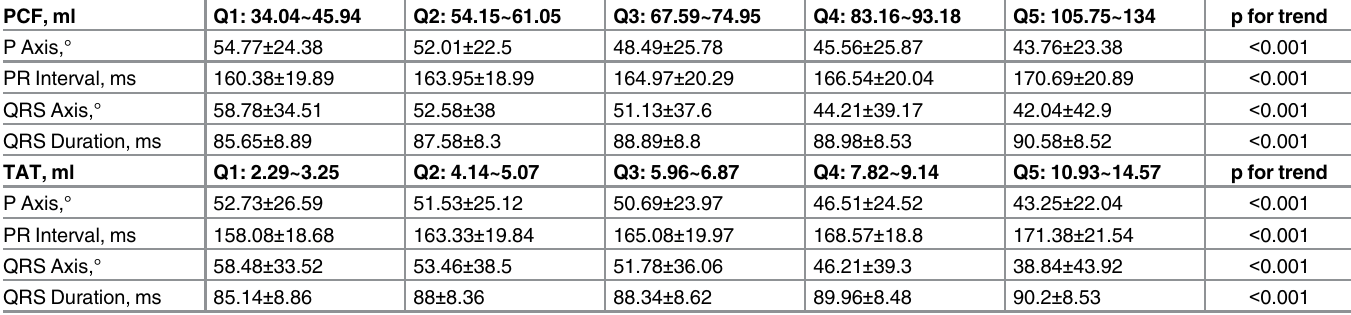
Table 3. Several body surface 12-lead ECG parameters across visceral adiposity stratification measures (PCF and TAT) in current study